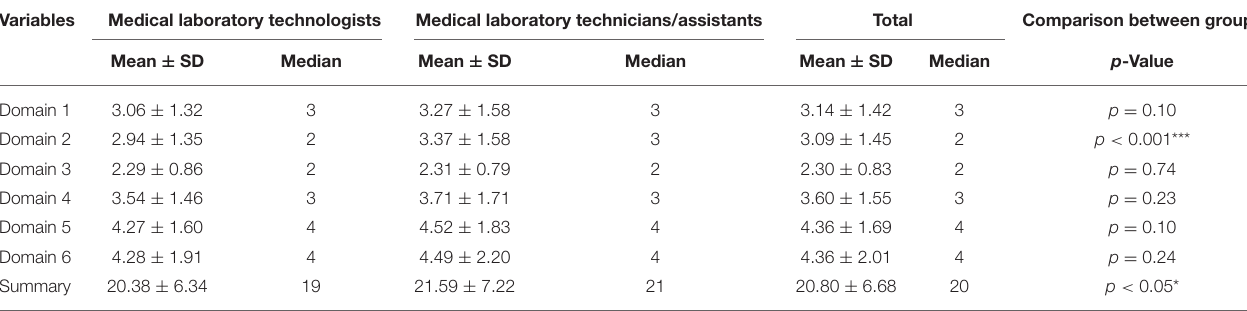
TABLE 3 | A comparison of the functional scores among respondents across the six domains of the WHODAS 2.0.